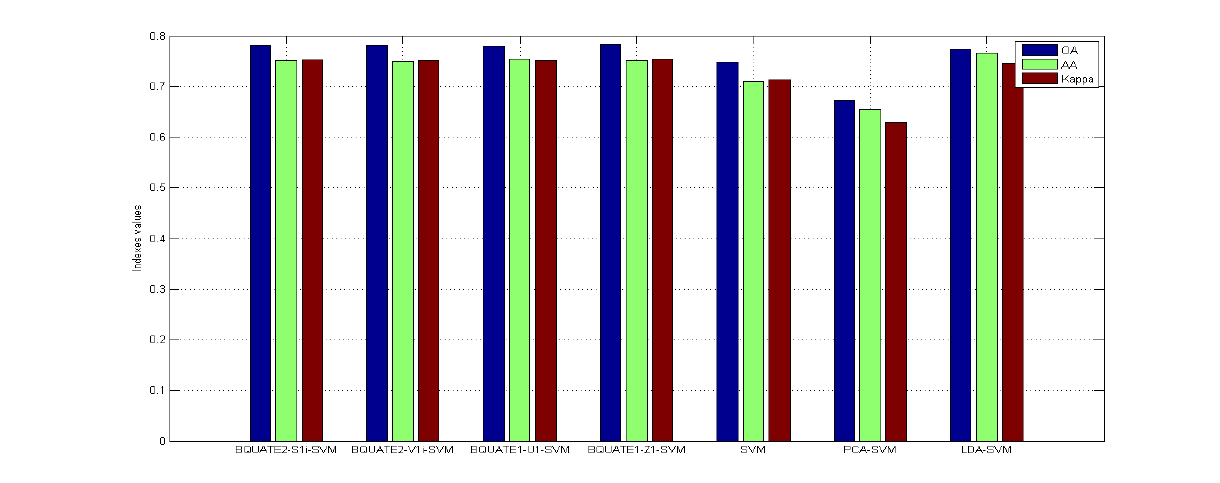
Figure 13. The OA, AA, Kappa values of BQUATE2-S1i-SVM, BQUATE2-V1i-SVM, BQUATE1-U1-SVM, BQUATE1-Z1-SVM, SVM, PCA-SVM, and LDA-SVM on Indian